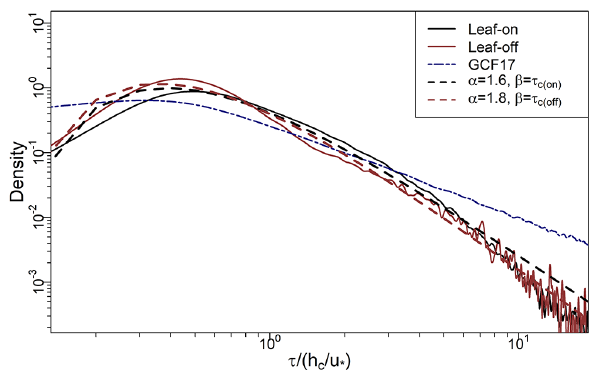
Figure 9. Solid black and red lines show PDFs of τ (Sect. 2.3) from BIFoR FACE (2.1 and Fig. 1) during the leaf-on and leaf-off periods, respectively (Sect. 2.2). Dashed lines show PDF estimates on the BIFoR FACE observations using Eq. (7). Navy dot–dash line shows PDF from GCF17 in Eq. (1). τ c(on) and τ c(off) denote τ c = h c /u ∗ for the leaf-on and leaf-off periods (Sect. 2.4). All τ values normalised by τ c = h c /u ∗